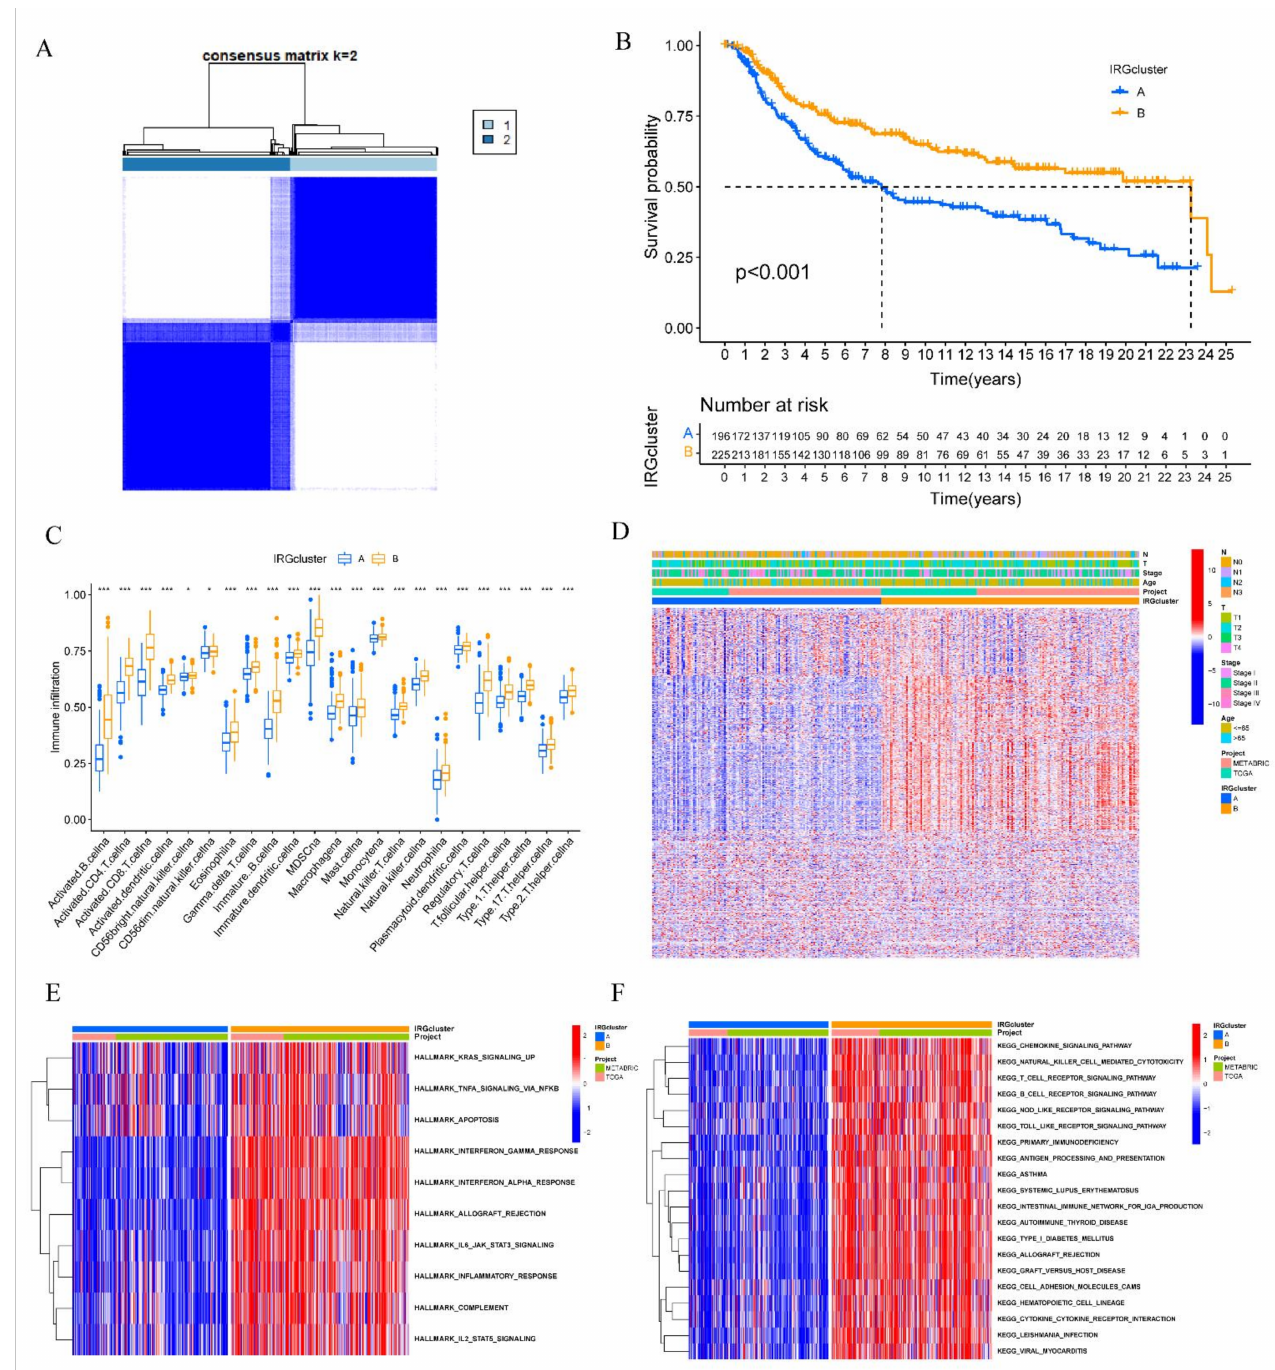
Figure 3. Identification of distinct IRGs subtypes in TNBC. ( A ) Consensus clustering matrix for k = 2 based on IRGs expression. ( B ) Kaplan–Meier curves of OS for two TNBC subtypes. The numbers of patients in IRGcluster-A and IRGcluster-B are 196 and 225, respectively. ( C ) The abundance of infiltrating immune cells in two IRGs subtypes. The lines in the boxes were the median value. The top and bottom ends of the boxes indicated interquartile range of values (* p < 0.05; *** p < 0.001). ( D ) Unsupervised clustering of IRGs expression to divide TNBC patients into two IRGs subtypes. The IRG clusters, projects, age, stage, tumor size, and node status were used as patient annotations. ( E , F ) Heat map showed the GSVA score of hallmark signature and KEGG pathways in different IRGcluster. Red means activated pathways and blue means inhibited